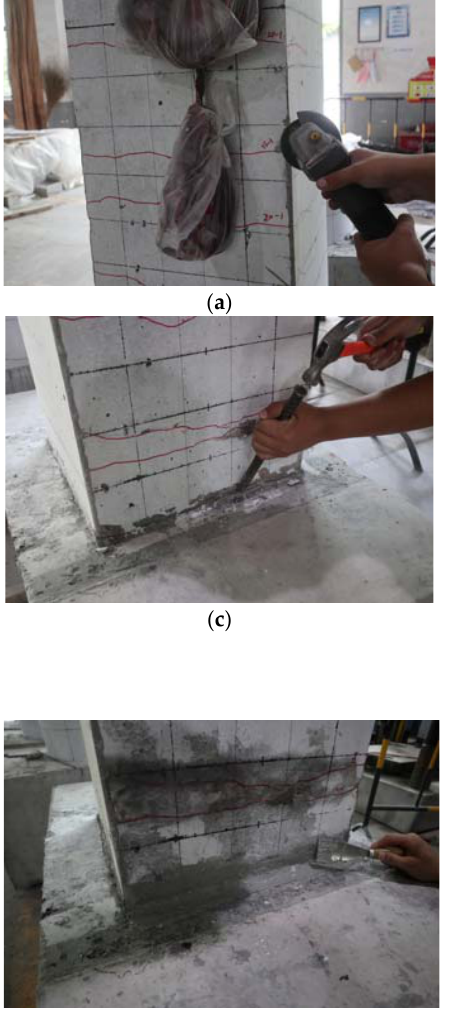
Figure 3. Repair design for the damaged precast column with CFRP fabrics.